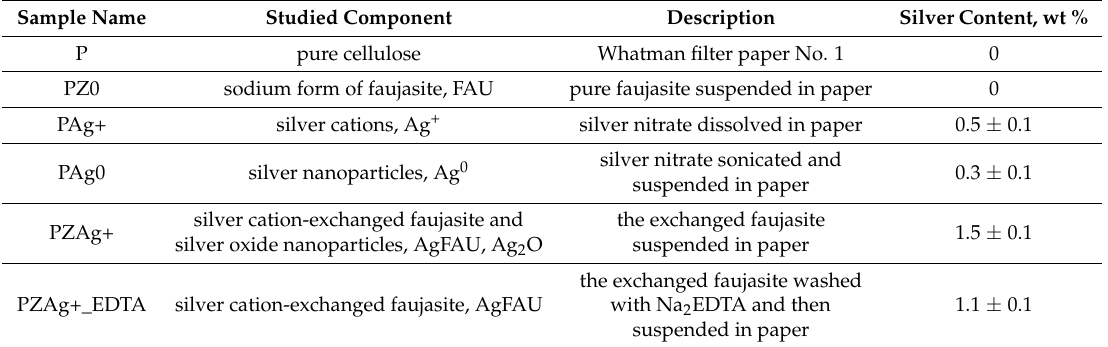
Table 1. Description of samples